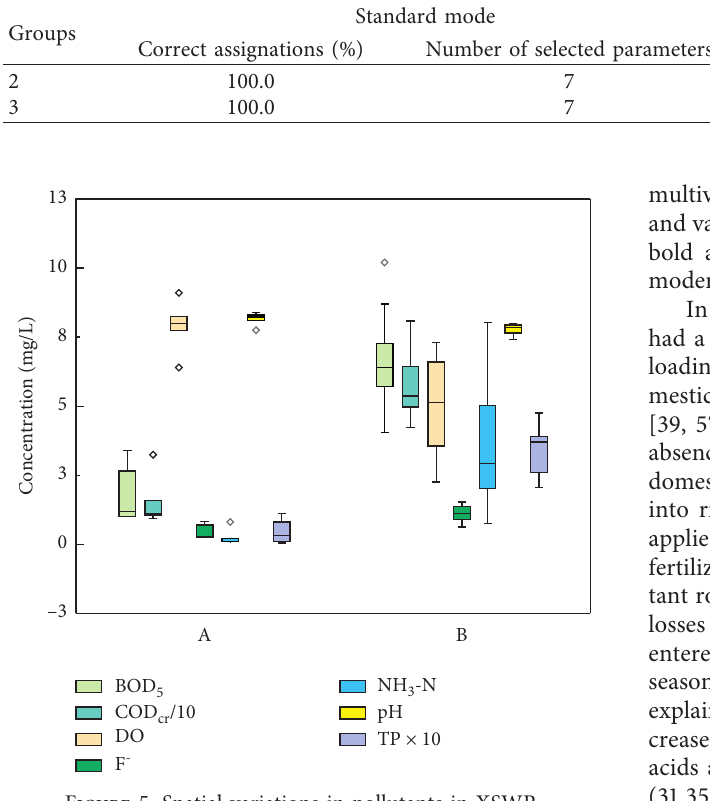
Figure 5: Spatial variations in pollutants in